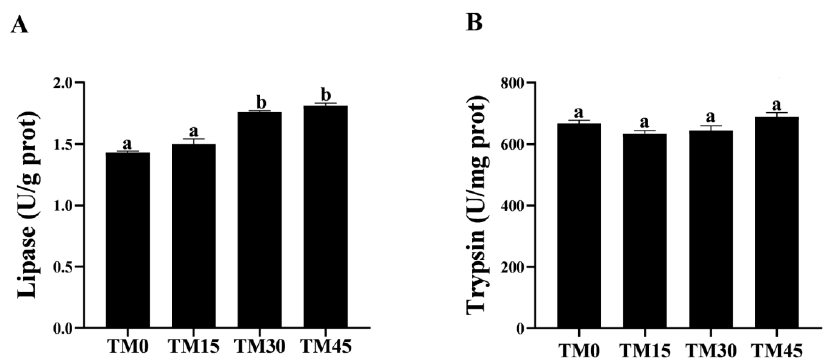
Figure 1. Digestion enzyme activity in the gut of large yellow croakers fed diets with different levels of TM ( Tenebrio molitor meal): ( A ) lipase and ( B ) trypsin. Bars with different letters (a, b) indicate a significant difference between experimental diets by Tukey’s test ( p < 0.05).